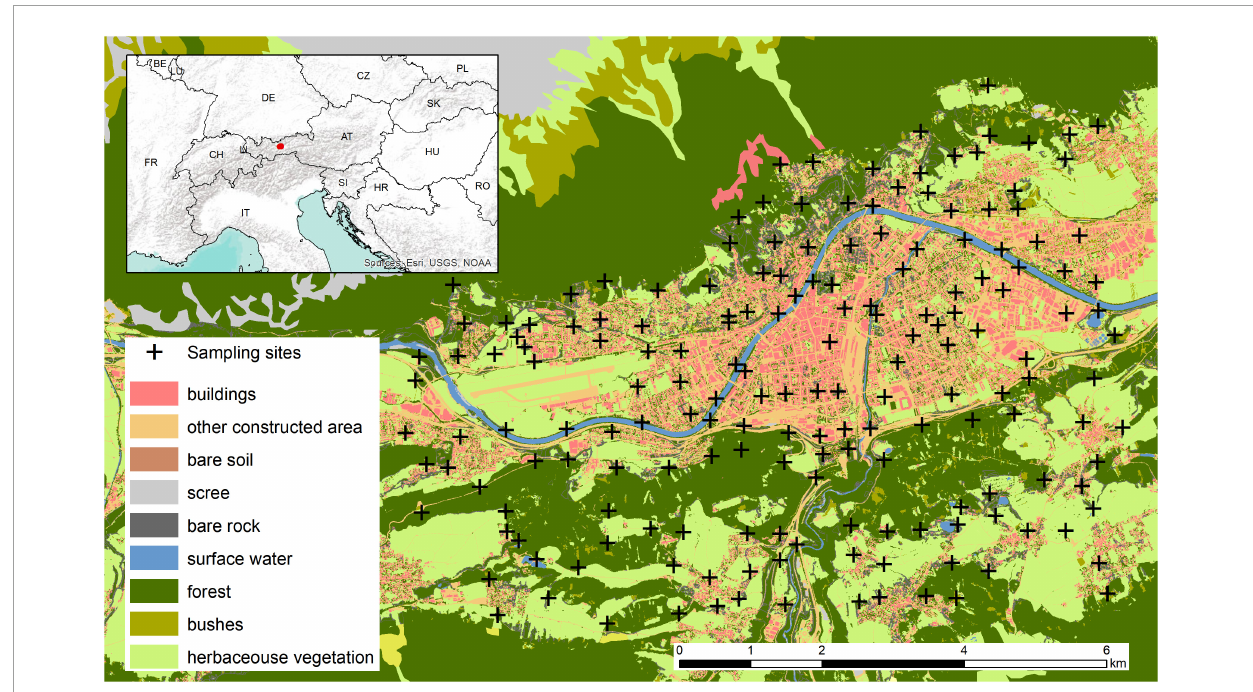
FIGURE1 Location of Innsbruck within Europe and overview of the 180 sites in Innsbruck and its surroundings where arthropods were sampled from October 2020 to August 2021. The map highlights the land cover in the sampling area extracted from the Land Information System Austria.